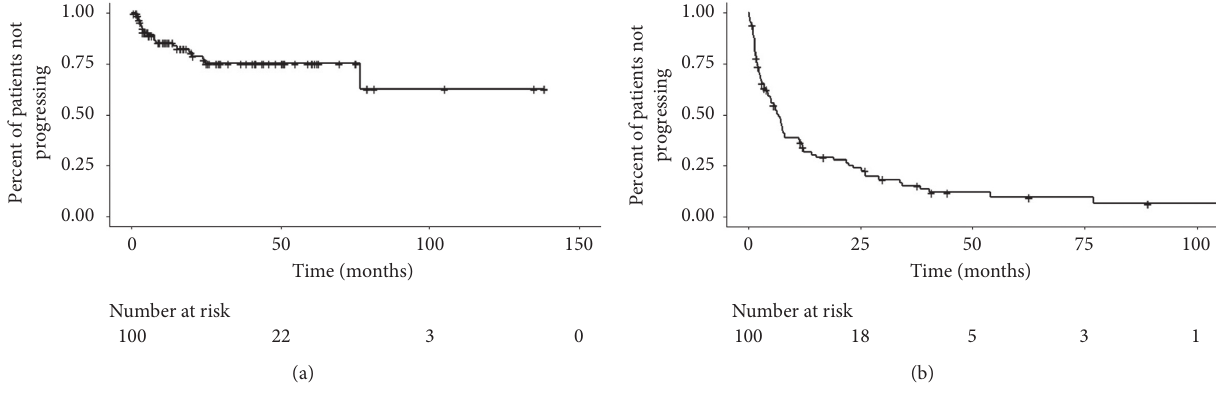
Figure 2: Progression-free survival. (a) Median local progression-free survival after ablation of sarcoma metastases was not reached. (b) Median distant progression-free survival was 6.7 months (95% CI: 4.4–11.2 months) after ablation of sarcoma metastases.